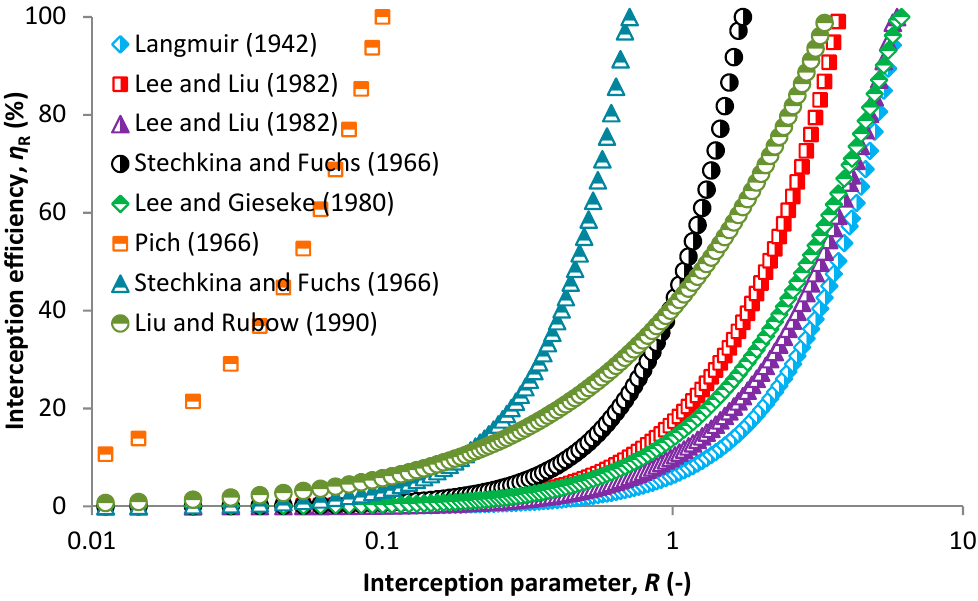
Figure 6. SCE due to interception based on various models in relation to interception parameter.